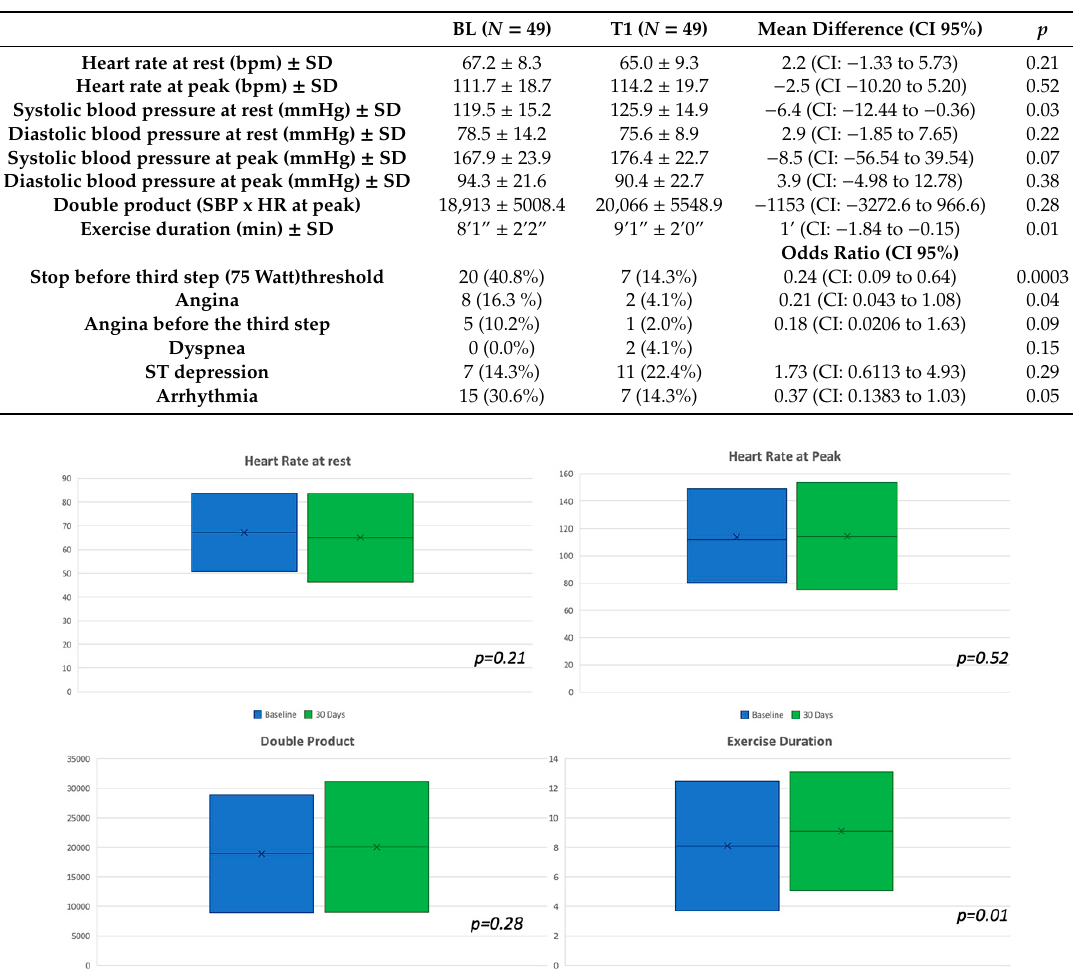
Table 3. Results of the Exercise echocardiogram (ECG) Test (EET) at baseline (BL) and after 30 days of therapy (T1). (SBP: systolic blood pressure. HR: heart rate).